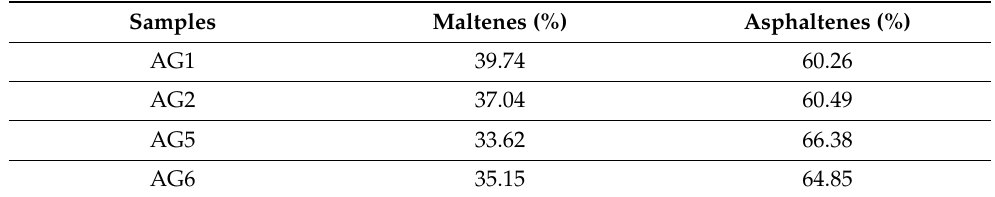
Table 4. Maltene and asphaltene content in the four analyzed samples.